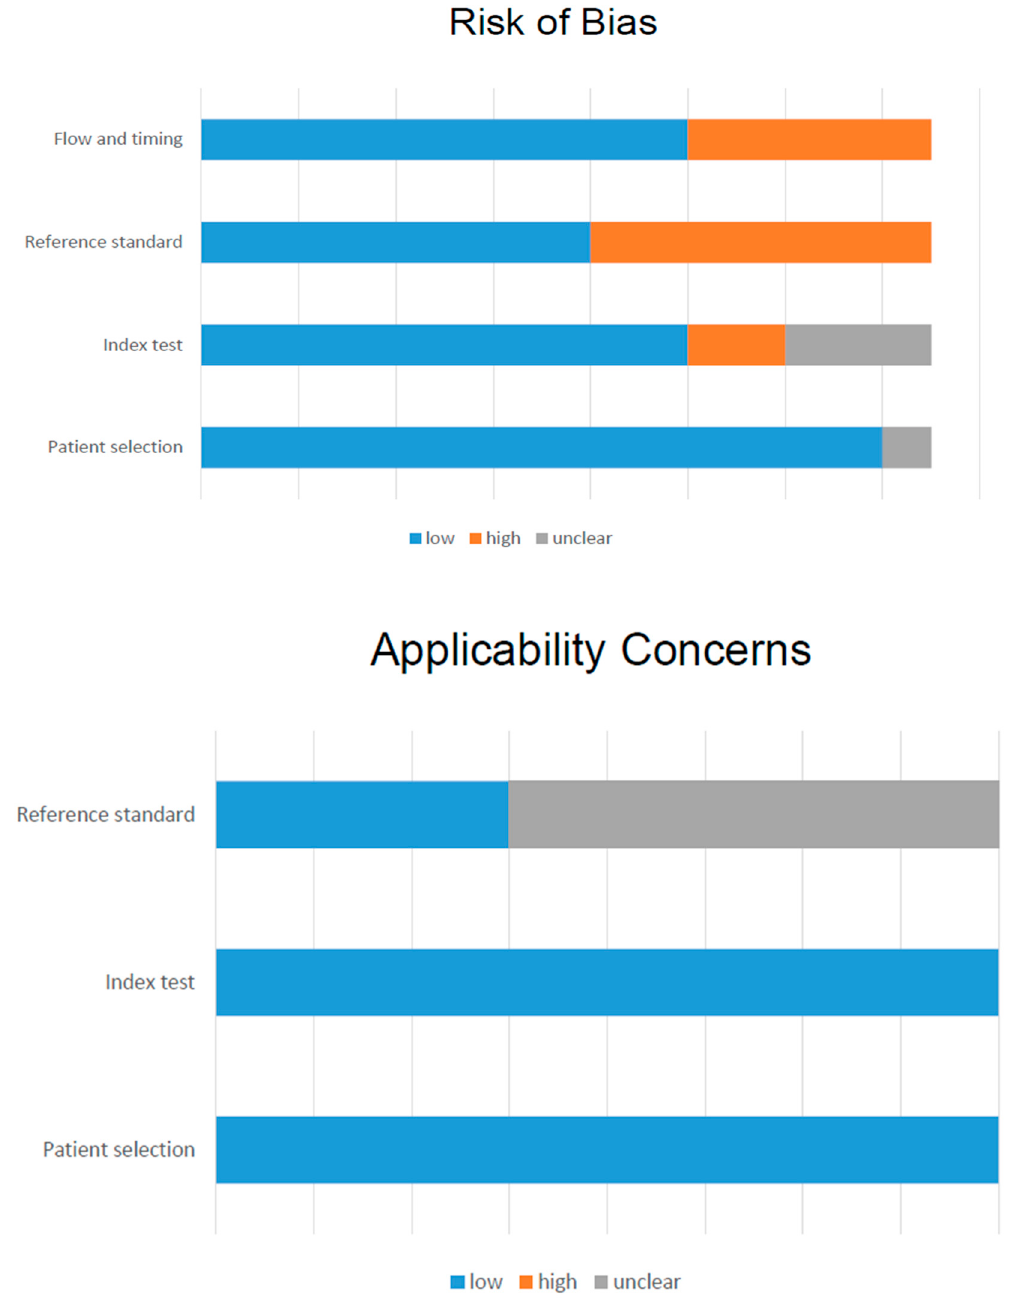
Figure 2. QUADAS 2 score of all included studies.